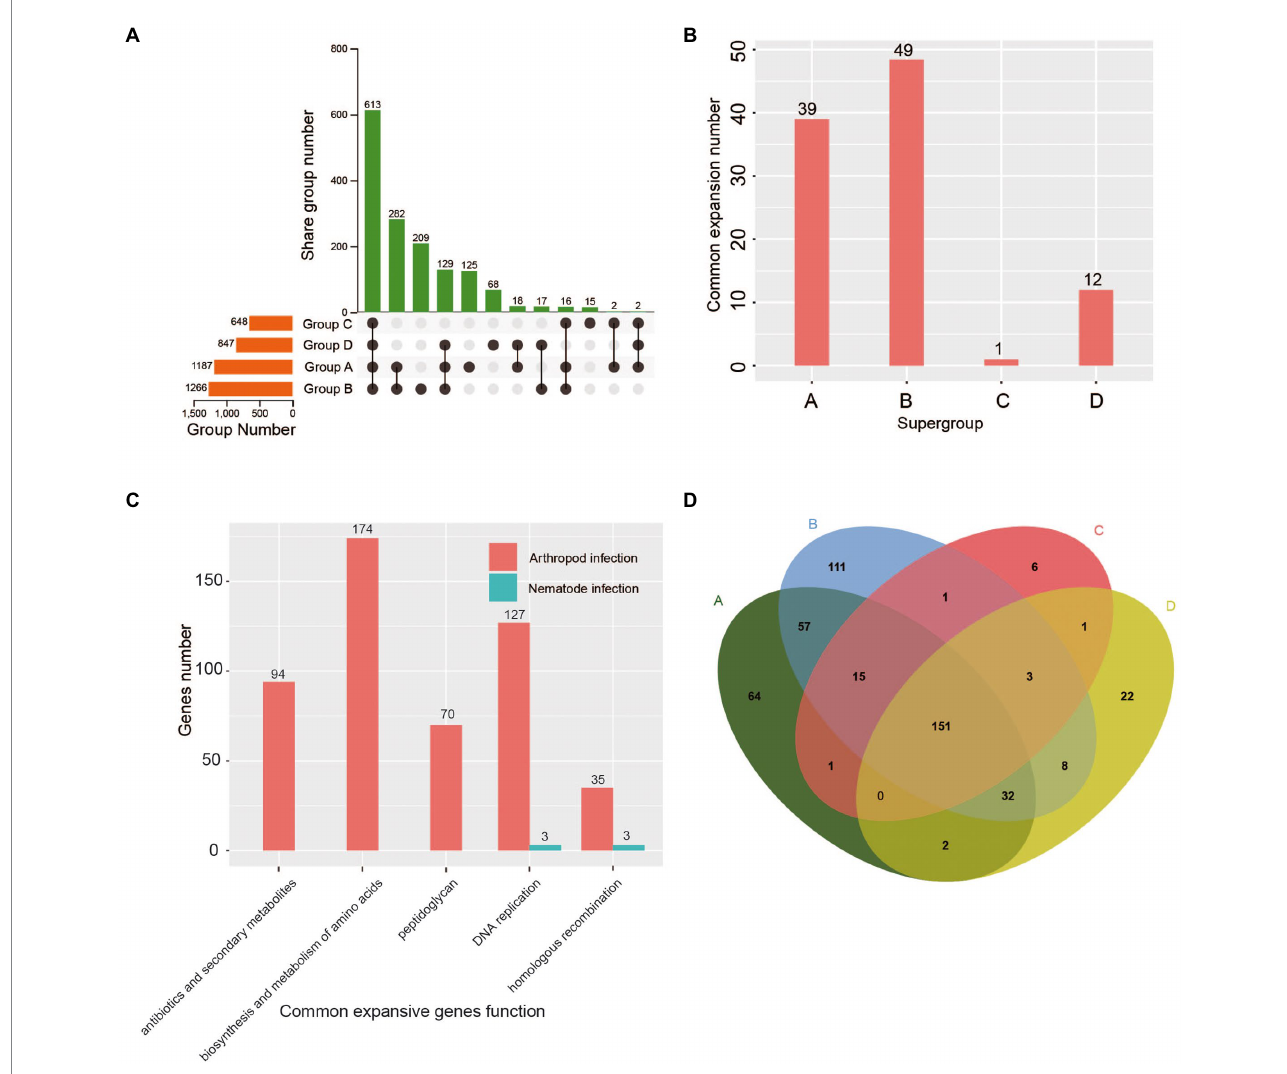
FIGURE 2 Comparison of gene families and functional enzyme expansions among the four Wolbachia supergroups (A, B, C, and D). (A) Unique and shared orthologous groups between and among the four supergroup genomes. (B) Number of coexpansive orthologous groups within each supergroup. (C) KEGG functional enrichment analysis of coexpanded genes in arthropod-infecting and nematode-infecting Wolbachia strains. (D) Venn diagram showing the number of unique and shared functional enzymes between and among the four supergroups, A, B, C and